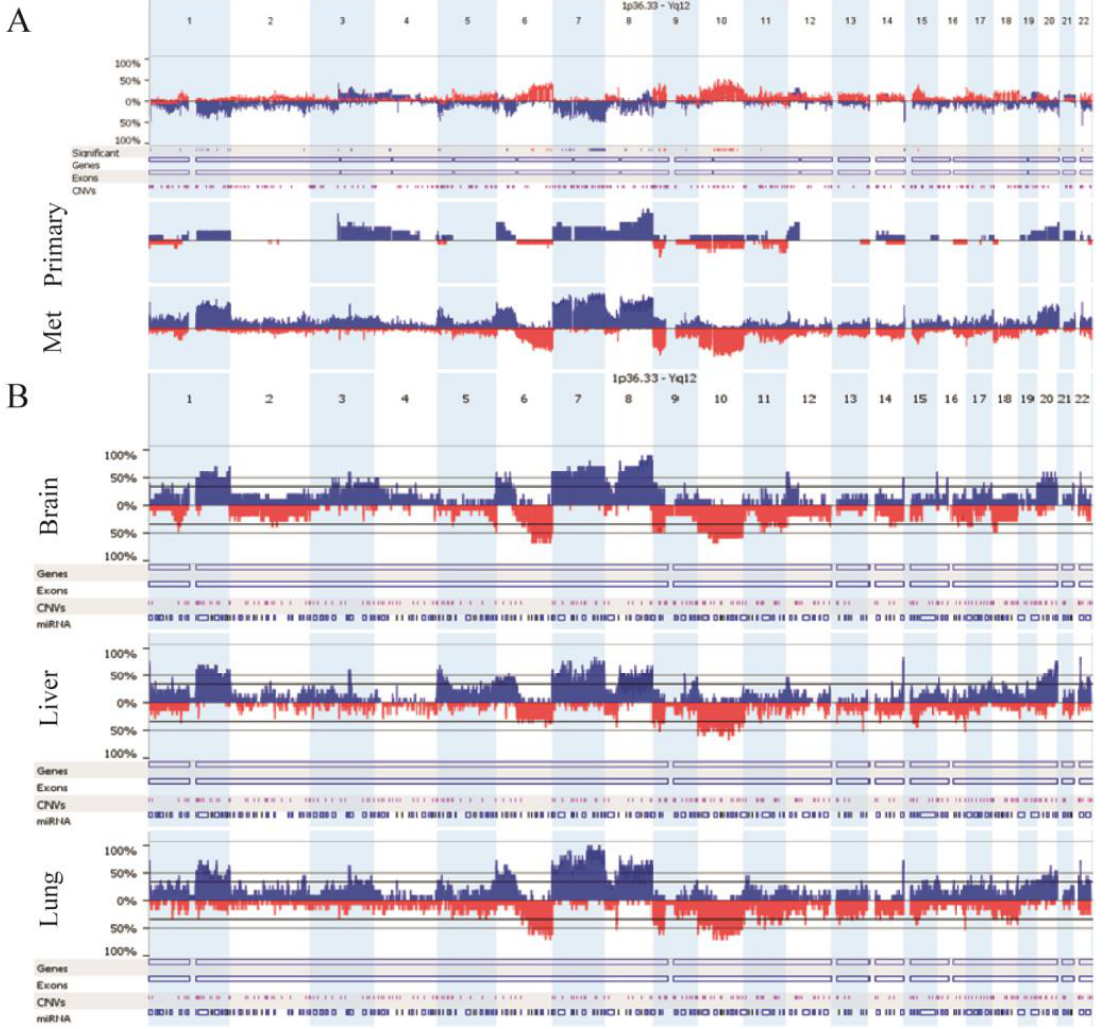
Figure 1. CNV landscape of examined melanoma samples: ( A ) primary tumors vs. distant melanoma metastases, ( B ) distinct distant metastatic sites (brain vs. liver vs. lung). Blue and red colors indicate copy number gains and losses, respectively.